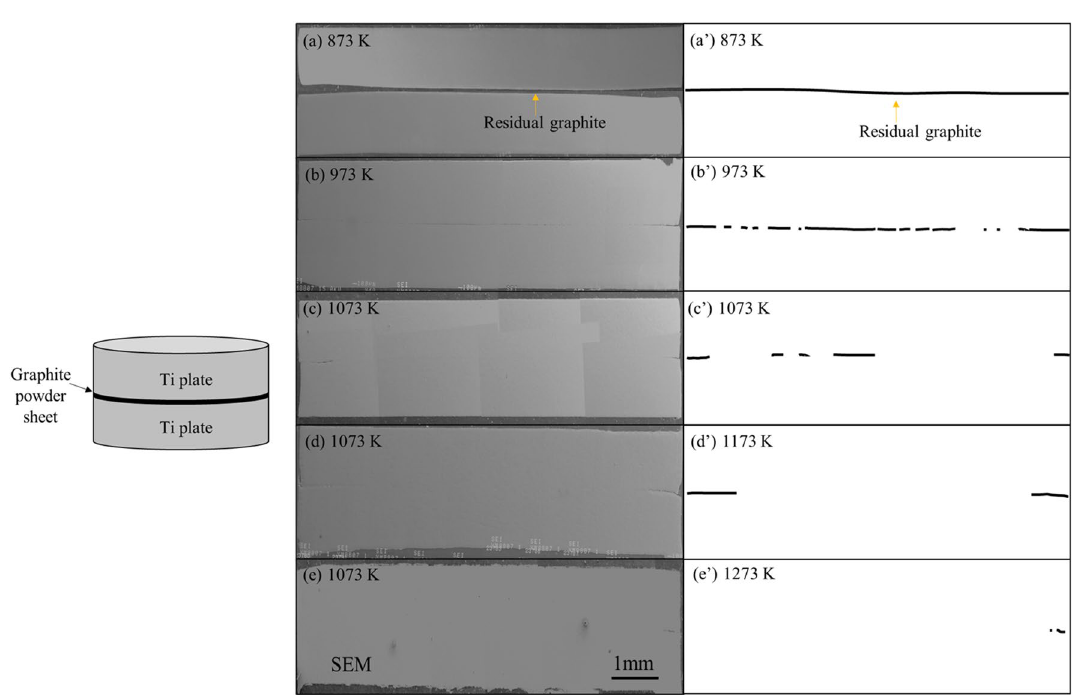
Figure 3. SEM images of Ti matrix composite by different of sintering temperature: 873 K( a ), 973 K( b ), 1073 K( c ), 1173 K( d ) and 1273 K ( e ); ( a ’)-( e ’): Corresponding replication view of the residual